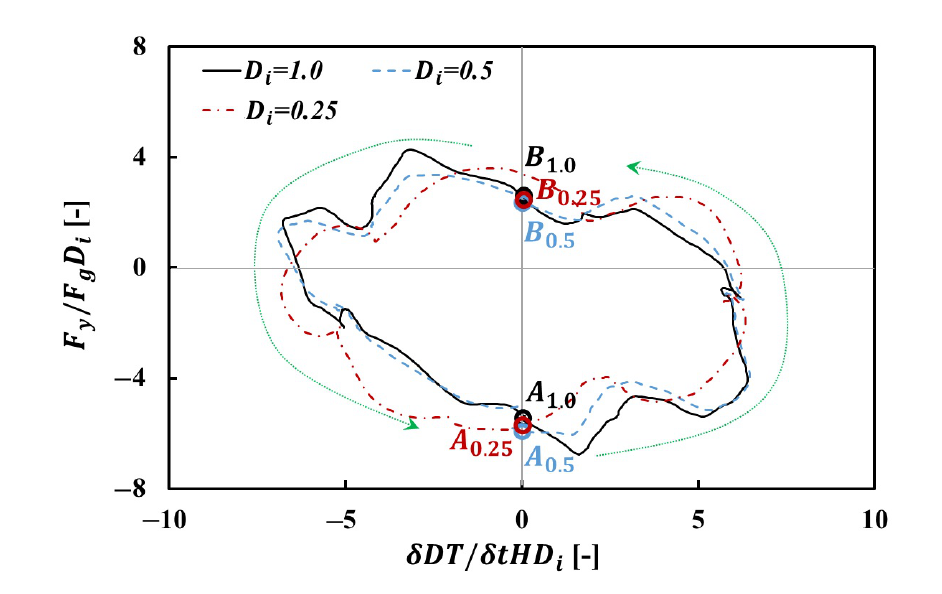
Figure 9. Normalised force-velocity diagram for the third oscillation cycle with N c =